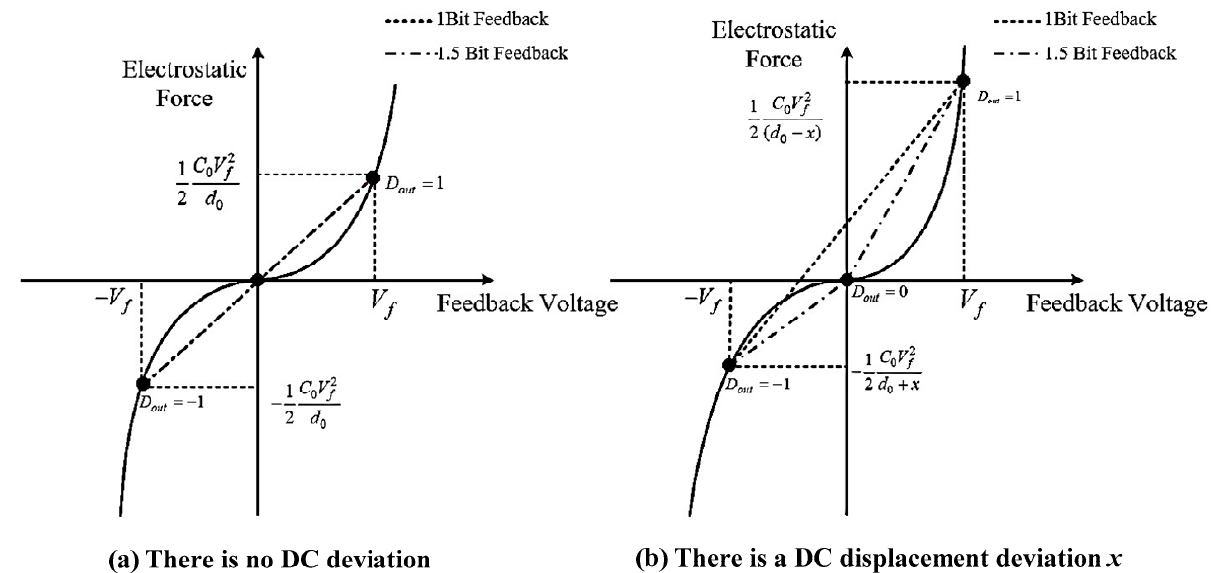
Figure 2. Comparison of the linearization effect between 1 − Bit Feedback and 1.5 − Bit Feedback.